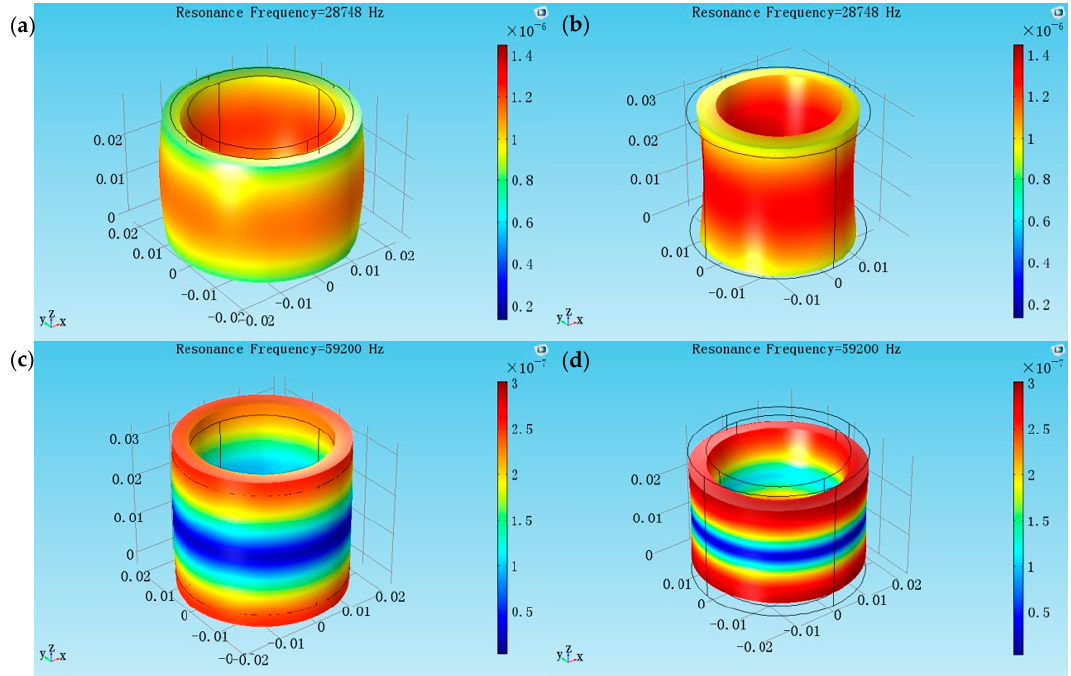
Figure 4. The coupled vibration modes of the cylindrical transducer at aspect ratio of l / 2b = 0.75. ( a , b ) The radial extensional vibration mode of the coupled vibration; ( c , d ) The longitudinal extensional vibration mode of the coupled vibration.